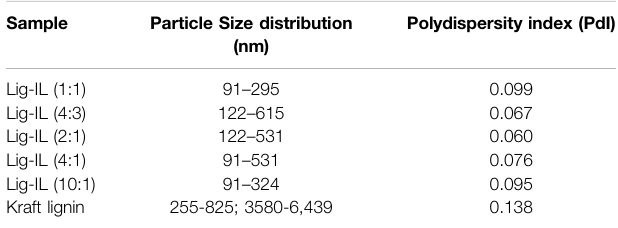
TABLE 1 | Particle size distribution and polydispersity index for all prepared materials.